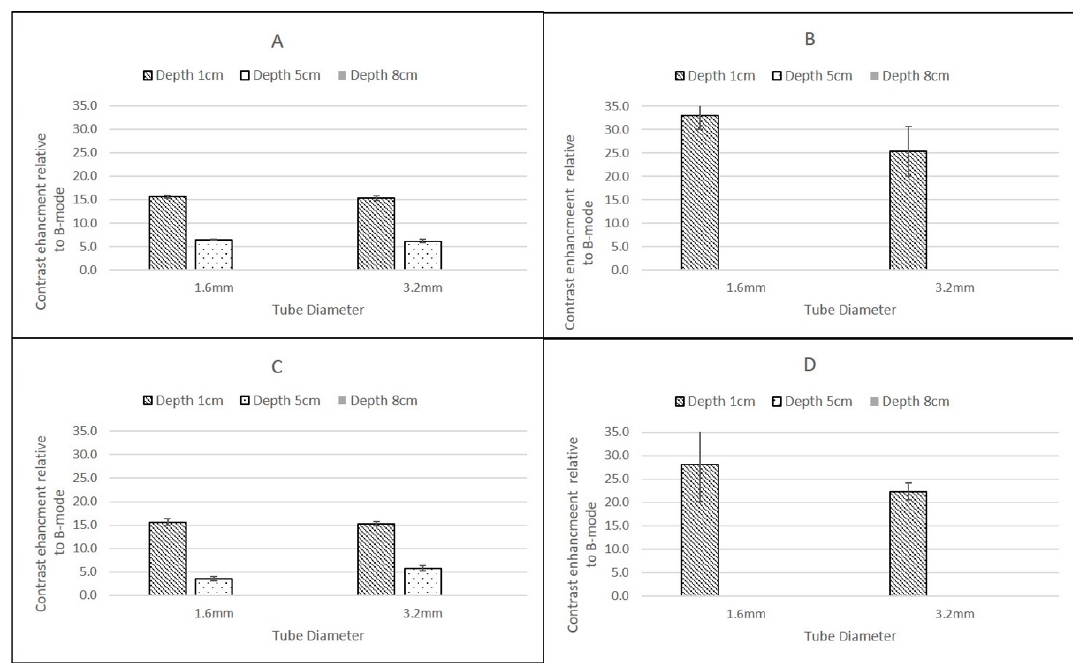
Figure 7. Ratio of backscatter signal in contrast-specific imaging mode to B-mode using an Esaote MyLab Twice LA523 probe for ( A ) SonoVue at a flow rate of 0.25 mL/s; ( B ) DEFINITY ® at a flow rate of 0.25 mL/s; ( C ) SonoVue at a flow rate of 1.5 mL/s; ( D ) DEFINITY ® at a flow rate of 1.5 mL \ L/s SonoVue. Note the change in scale on vertical axis compared to Figures 5 and 6. Error bars are standard